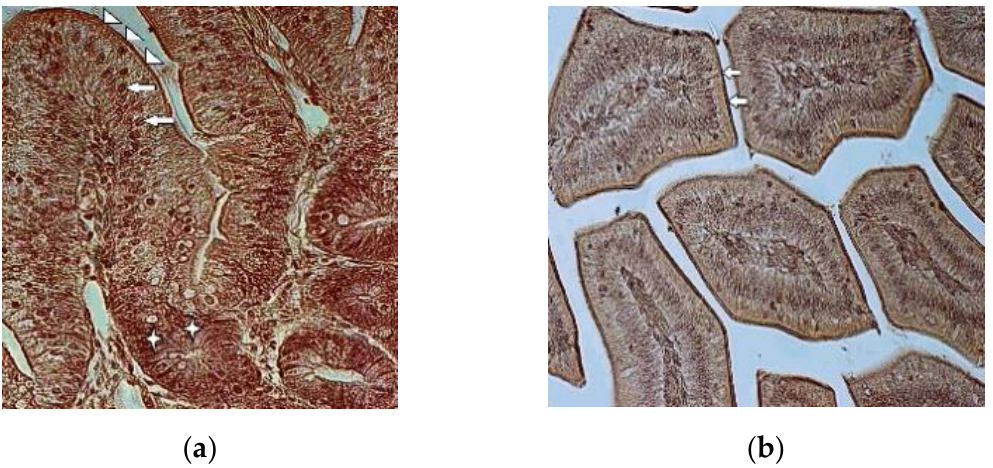
Figure 2. (a) Expression of GLUT-5 in seven-day-old broiler’s duodenal epithelium (control group). Strong staining for GLUT-5 in brush border membrane (arrowheads) and nuclei of enterocytes (arrows). Note the strongly stained cells in the intestinal crypts (asterisks) 400×; ( b ) Expression of GLUT-5 in seven-day-old toxicated broiler’s duodenal epithelium. The cytoplasm and nuclei of enterocytes are stained weakly. Note the strongly stained brush border membranes (arrows) 200×.